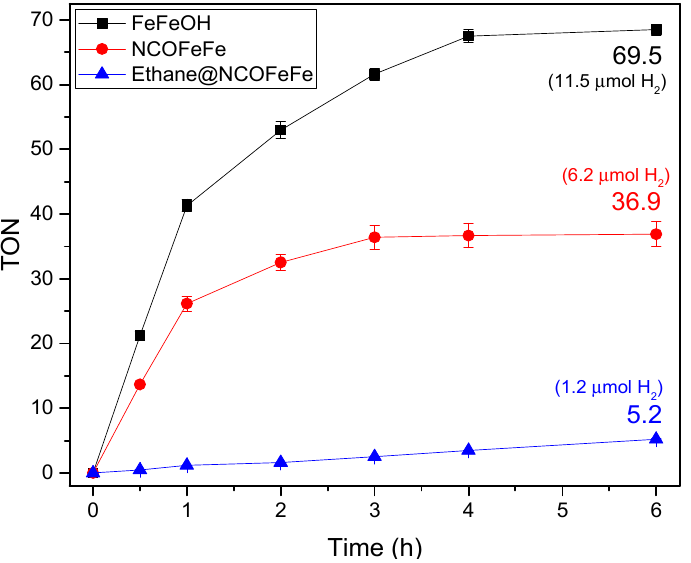
Figure 11. Photocatalytic hydrogen production under standard conditions (0.084 mM of the homogeneous catalyst, 0.5 mM of Ru(bpy) 32+ , 100 mM of ascorbic acid, and 1 M of the acetate buffer at pH 5.0) in the homogeneous phase (ACN/H 2 O with a 11.8 vol% organic phase) using FeFeOH and NCOFeFe. Similar conditions were stablished in the heterogeneous phase with the only difference being the solvent, i.e., milli-Q water solution, and using 2 mg of EthanePMO@NCOFeFe.